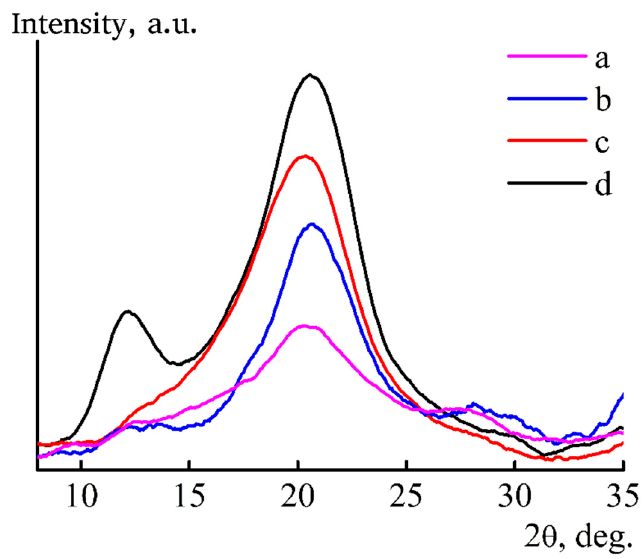
Figure 14. X-ray diffractograms of cellulose films formed in IPA (T = 80 °C) and then aged in alcohol (a,c) or water (b,d) and dried at room conditions in transmission (a,b) and reflection (c,d) modes.